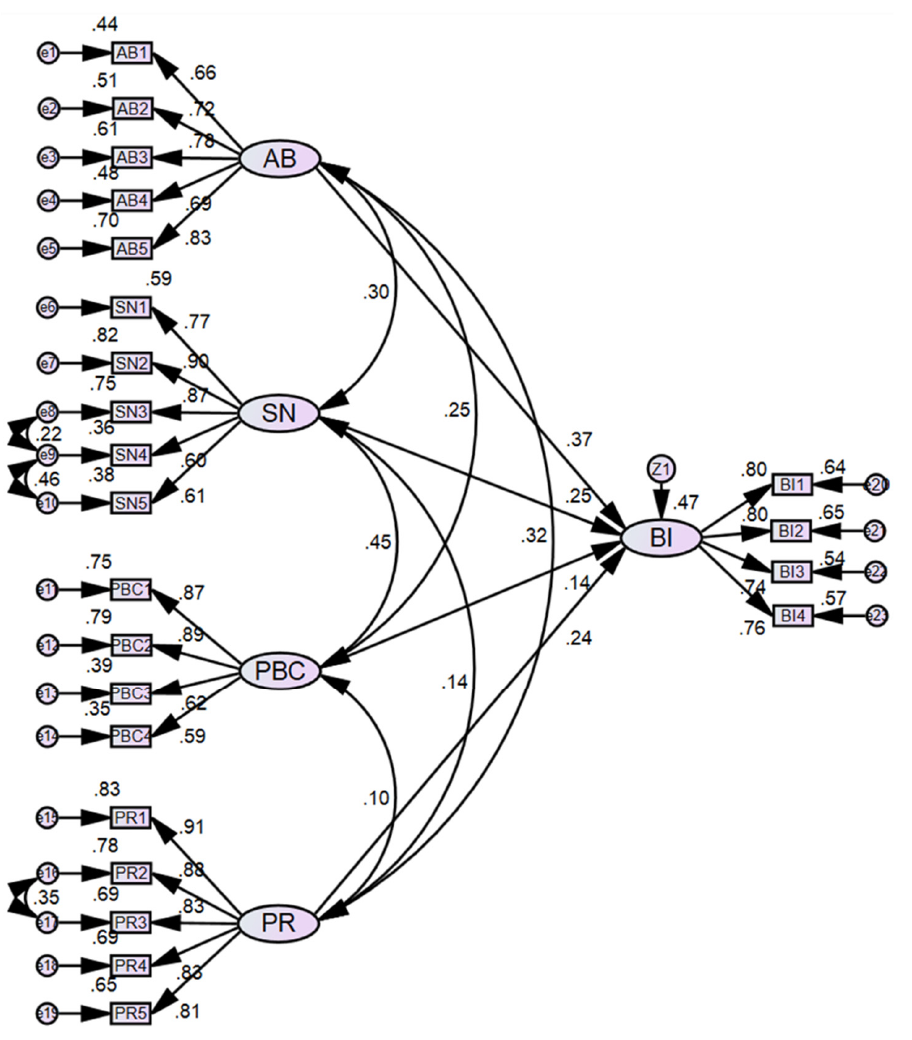
Figure 4. Standardized estimation of the final model. Table 7. Regression weights in the final